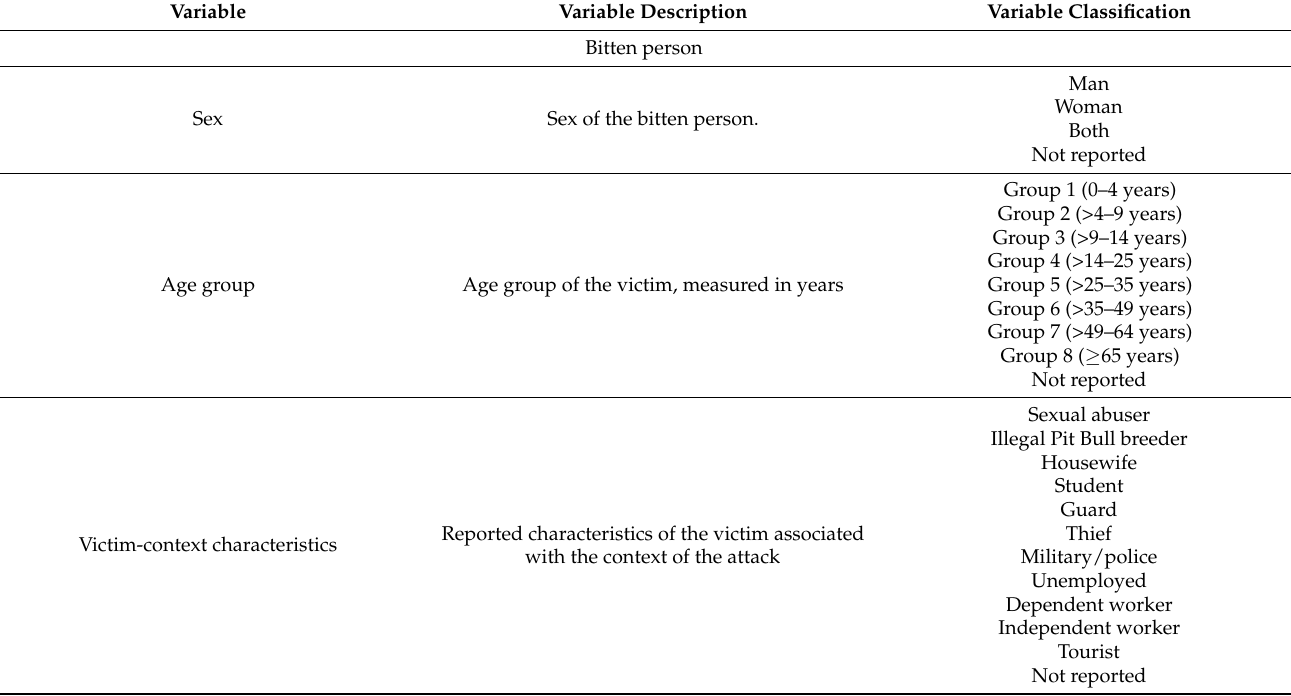
Figure 1. Flow chart used for the systematic review. Meaning of abbreviations: CH: Chile, SP: Spain, FT: Full text and N°: Number. Table 3. Classification of the variables of interest for further